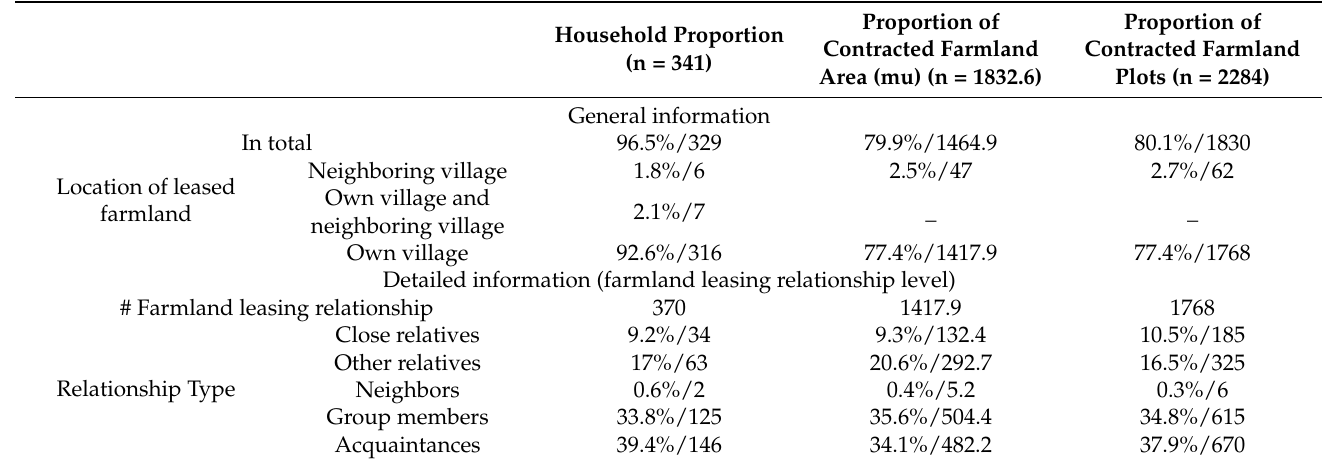
Table 3. Farmland leasing of Huang village in